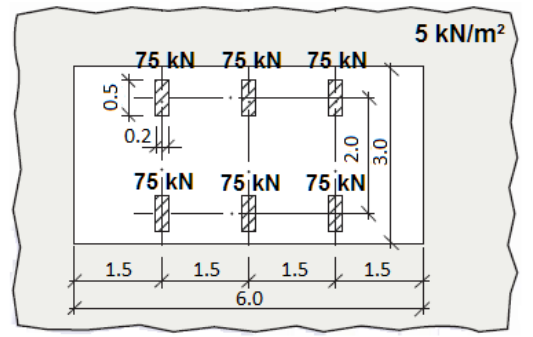
Figure 2. Brazilian live load model, dimensions in meters (adapted from NBR 7188